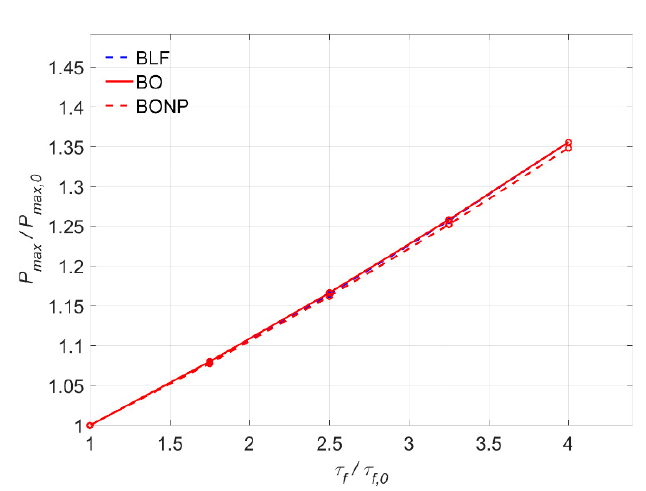
Figure 21. Variation of P max versus τ f .